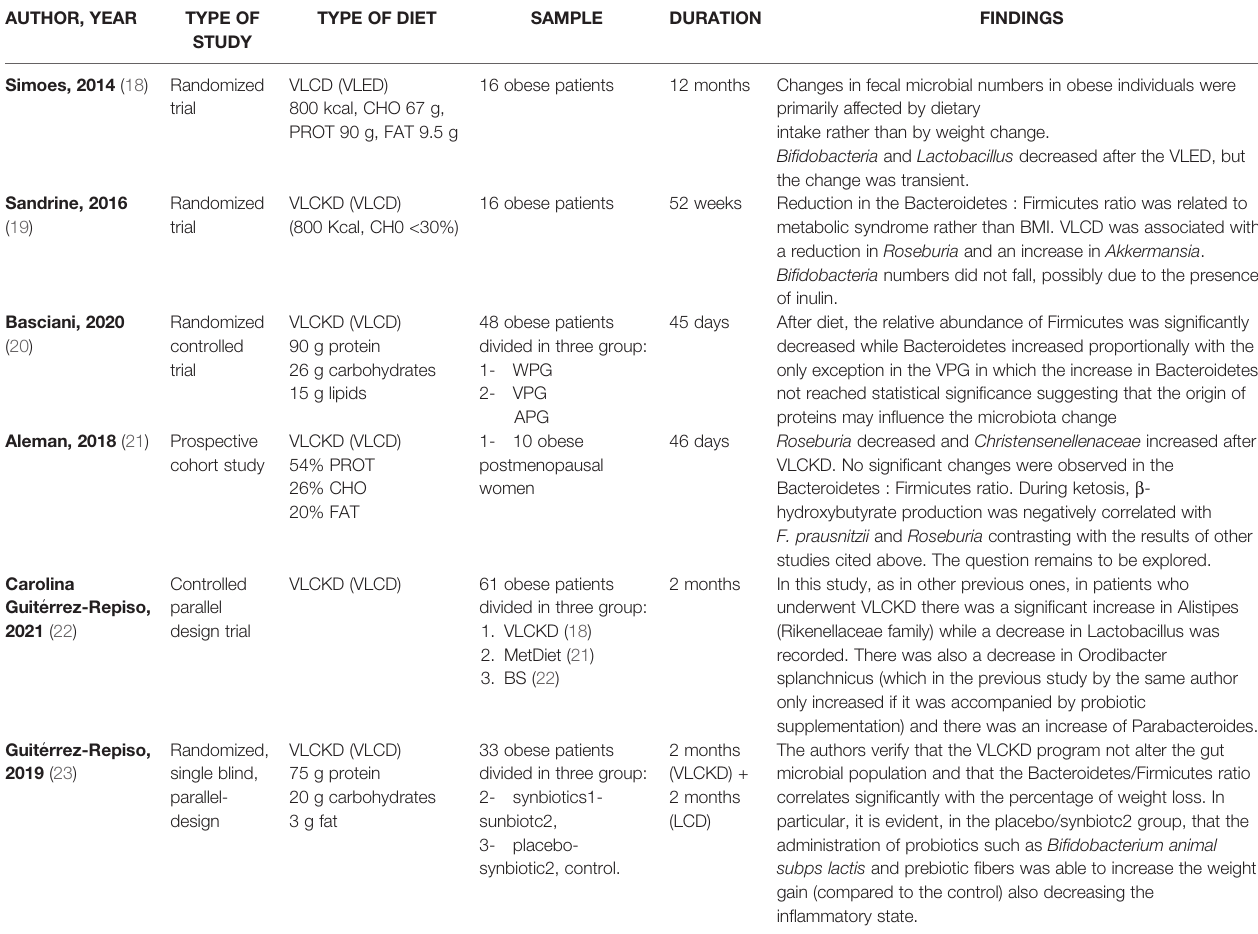
TABLE 1 | Studies on the effects of VLCDs on gut